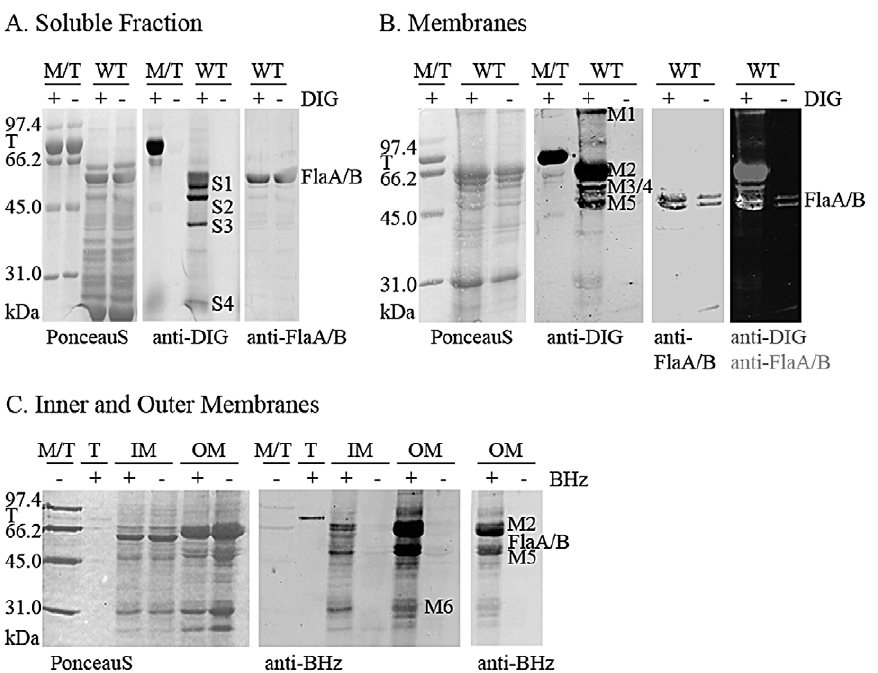
Figure 5. Analysis of the GPs from the soluble and membrane fractions of the WT H.pylori strain by SDS-PAGE gel and DIG labeling. The cells were lysed by mechanical disruption, separated into the soluble (Panel A) and membrane (Panel B) fractions by ultracentrifugation. The membrane fraction was also separated in its inner and outer membrane components (Panel C, IM and OM, respectively). The proteins were labeled with DIG- (Panels A and B) or biotin- (panel C) hydrazide ( + ) or not ( 2 ), and separated on a SDS-PAGE gel. The GPs were detected by anti-DIG Western blotting (Panels A and B, red in overlay) or streptavidin Western blotting (Panel C). An anti-flagellin Western blot (green in overlay) was also performed to show that most GPs detected are not flagellins. M/T: molecular weight marker in which the glycoprotein transferrin was added to serve as a positive control for the DIG/Biotin blots. T: transferrin only. BHz: biotin hydrazide. The most DIG/biotin-reactive GPs are labeled on each panel. The anti-biotin blot of the OM is provided at two levels of exposure to allow visualization of the low reactivity band M6 and the doublet constituting the high reactivity band M2.